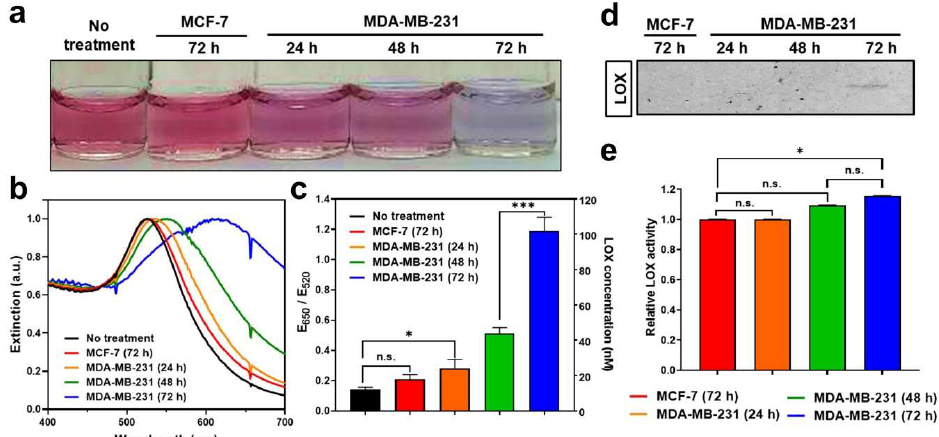
Figure 5. ( a ) Photographs of LS-AuNP suspension before or after the addition of conditioned media collected from a 72-h culture of MCF-7 cells; 24-h, 48-h, and 72-h cultures of MDA-MB-231 cells; ( b ) corresponding UV/Vis absorption spectra; and ( c ) E 650 /E 520 values. ( d ) Western blot analysis of LOX proteins contained in conditioned media collected from culture incubated for different periods. Original Western Blot figure can be found in Supplementary Materials. ( e ) LOX detection in different conditioned media using a commercially available LOX assay. n.s. indicates not significant ( p > 0.05), whereas the asterisk indicates significant difference (* p < 0.05 and *** p < 0.001).